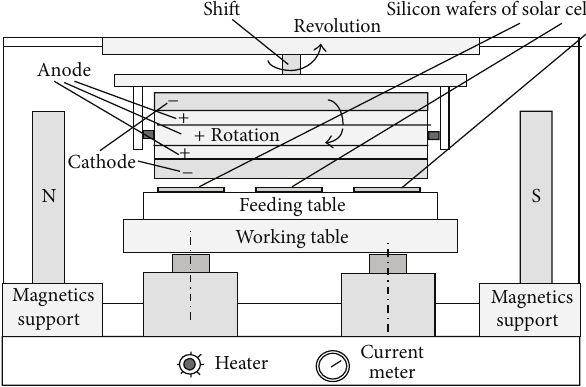
Figure 2: Configuration of the magnetic assistance